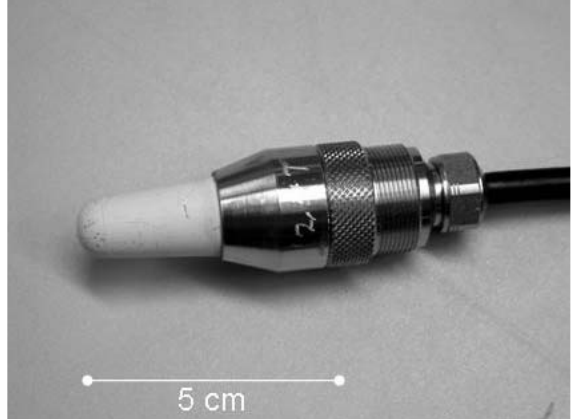
Figura 1. Ilustração de um tensiômetro de polímeros com dimensão aproximada, com a cápsula porosa (cerâmica clara) e o compartimento de aço contendo polímero e transdutor de